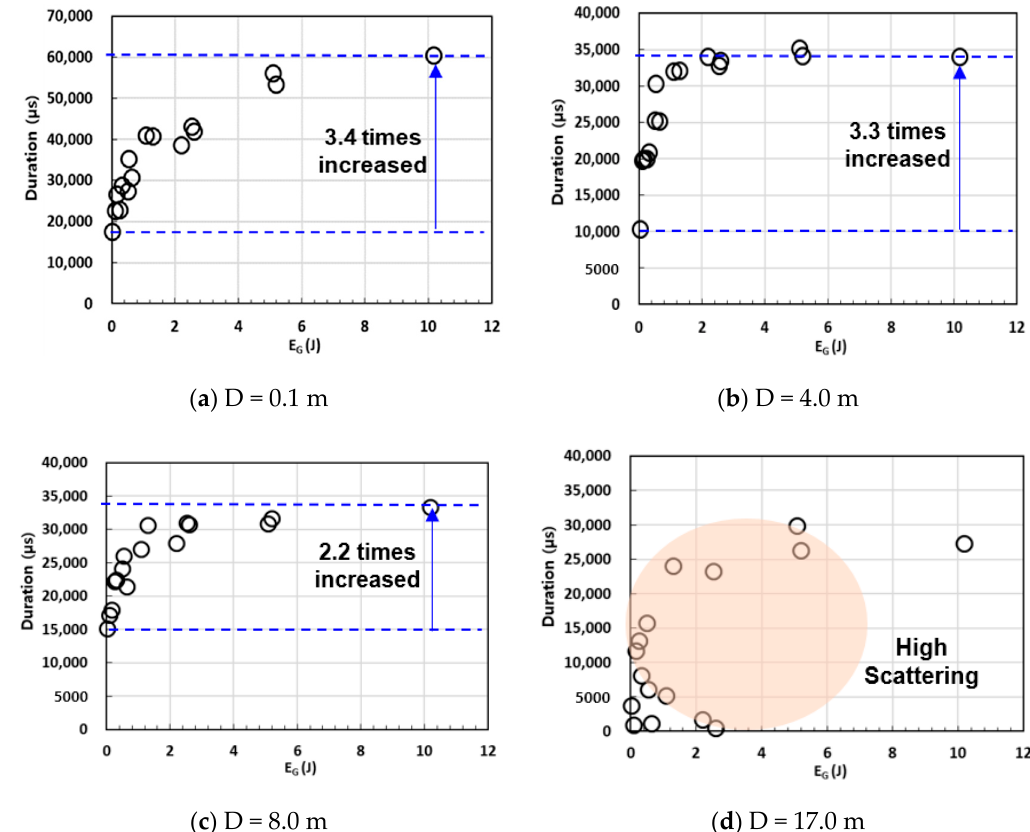
Figure 7. Duration according to impact energy.